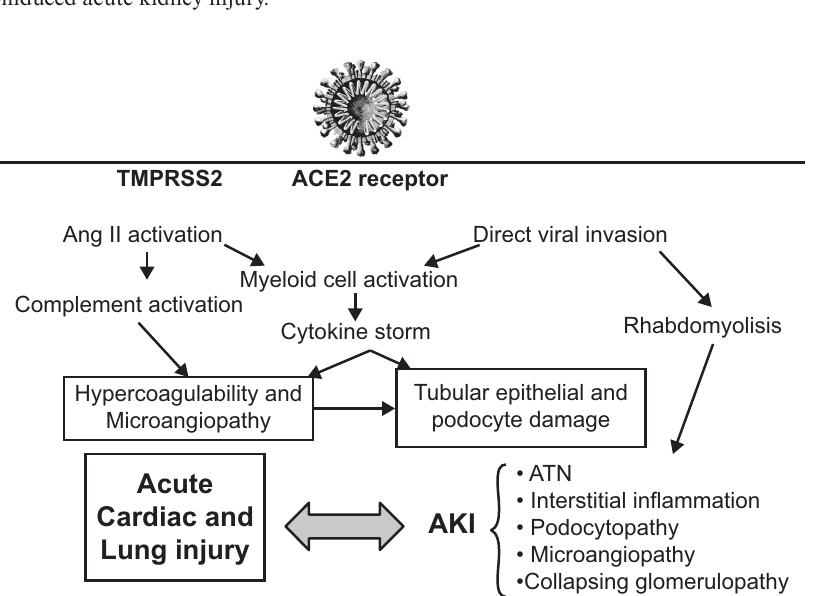
Figure 2. Coronavirus mechanisms of action and damage to the